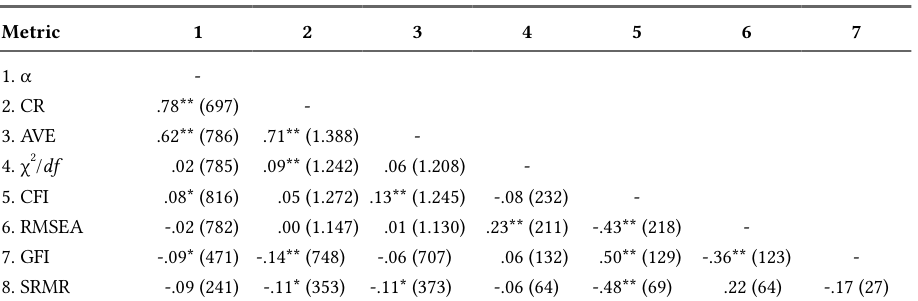
Correlations of Reliability Indices and Model Fit